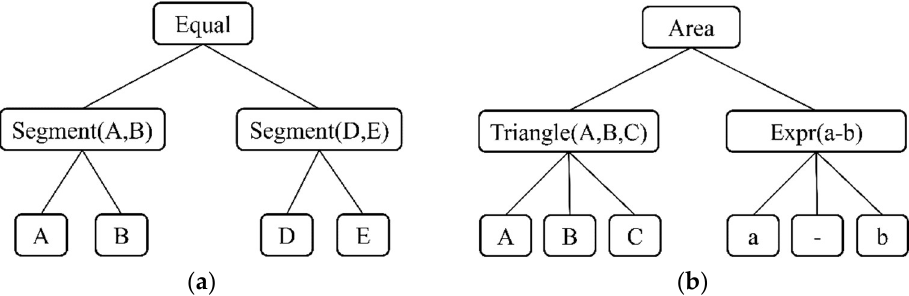
Figure 1. Knowledge tree. ( a ) KT of a constraint predicate. ( b ) KT of a metric